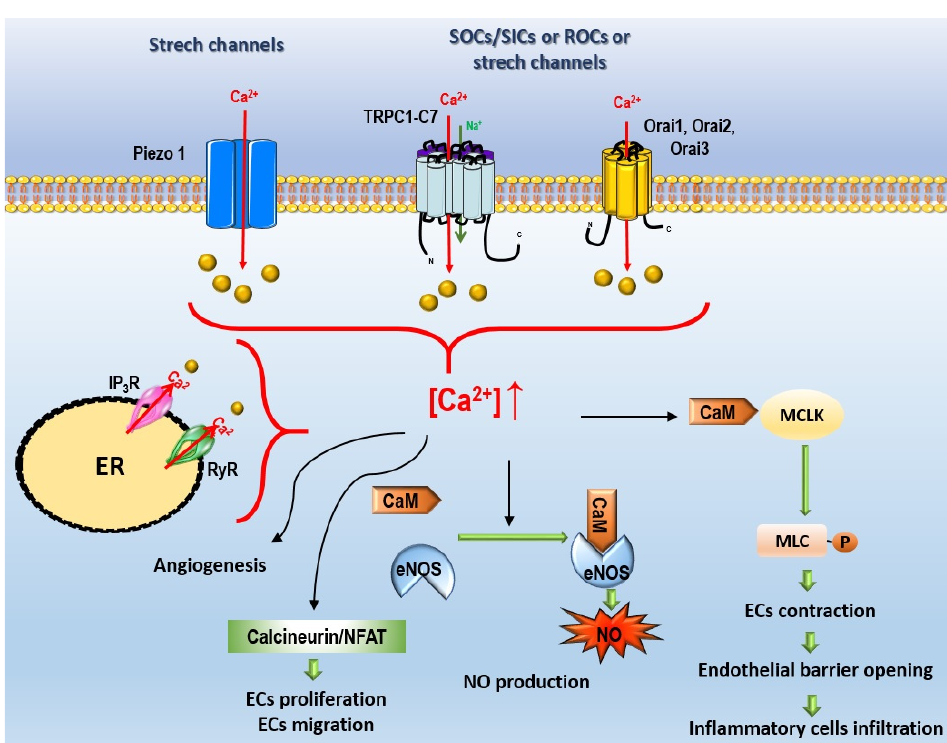
Figure 4. Signaling pathways arising following non-voltage Ca 2+ activation in PAECs. Calmodulin (caM); endoplasmic reticulum (ER); endothelial cells (ECs); endothelial nitric oxide synthase (eNOS); inositol triphosphate receptor (IP3R); myosin light-chain kinase (MLCK); myeloid cell leukemia (MCL); nitric oxide (NO); nuclear factor of activated T cells (NFAT); store-inhibited channels (SICs); storage-operated Ca 2+ entry (SOCE); store-operated channels (SOCs); receptor-operated channels (ROC); ryanodin receptor (RyR); transient receptor potential canonical channels (TRPC).